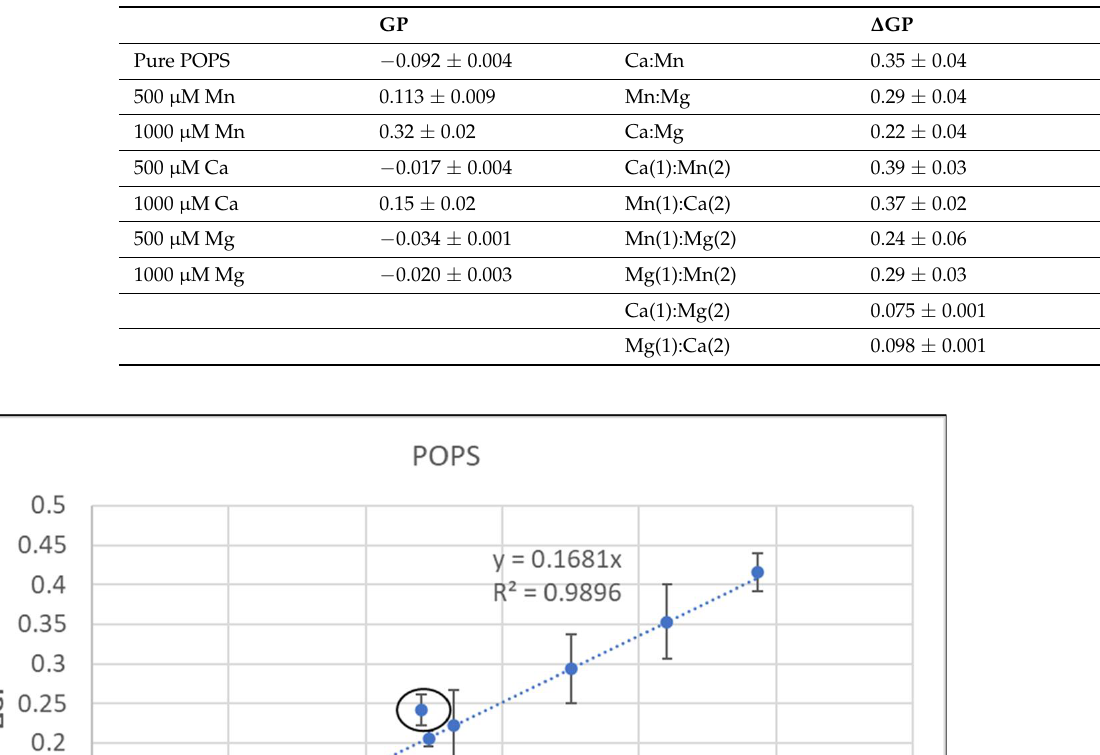
Table 5. Tabulated GP and ∆ GP values of POPS with varying concentration of Mn, Ca, Mg and metal mixtures.